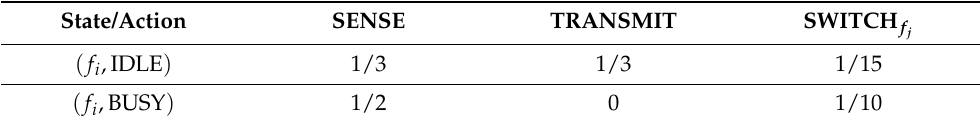
Table 3. Target policy parameters.